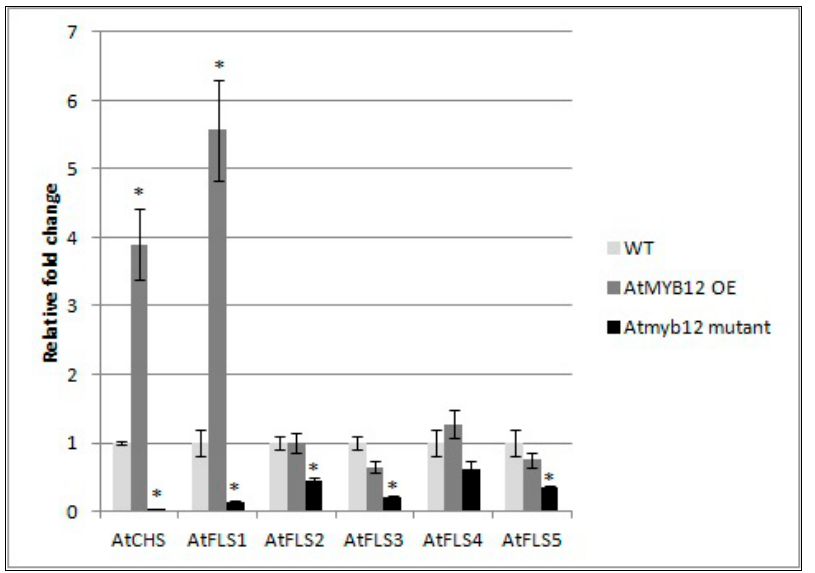
Figure 6. Effect of AtMYB12 on the expression of AtFLS genes. Expression of AtCHS and AtFLS1 , AtFLS2 , AtFLS3 , AtFLS4 , and AtFLS5 in plants overexpressing AtMYB12 , Atmyb122 knockout, and wild-type Col-0 (WT) seedlings using quantitative real-time PCR (qRT-PCR). The presented data are the mean fold changes ± standard errors in gene transcript levels relative to uninfected control tissue (baseline set at 1.0). Asterisks (*) indicate that the mean fold change is significantly different from 1.0 as determined by t test ( p < 0.05). Similar results were obtained from a second, independent biological replicate.